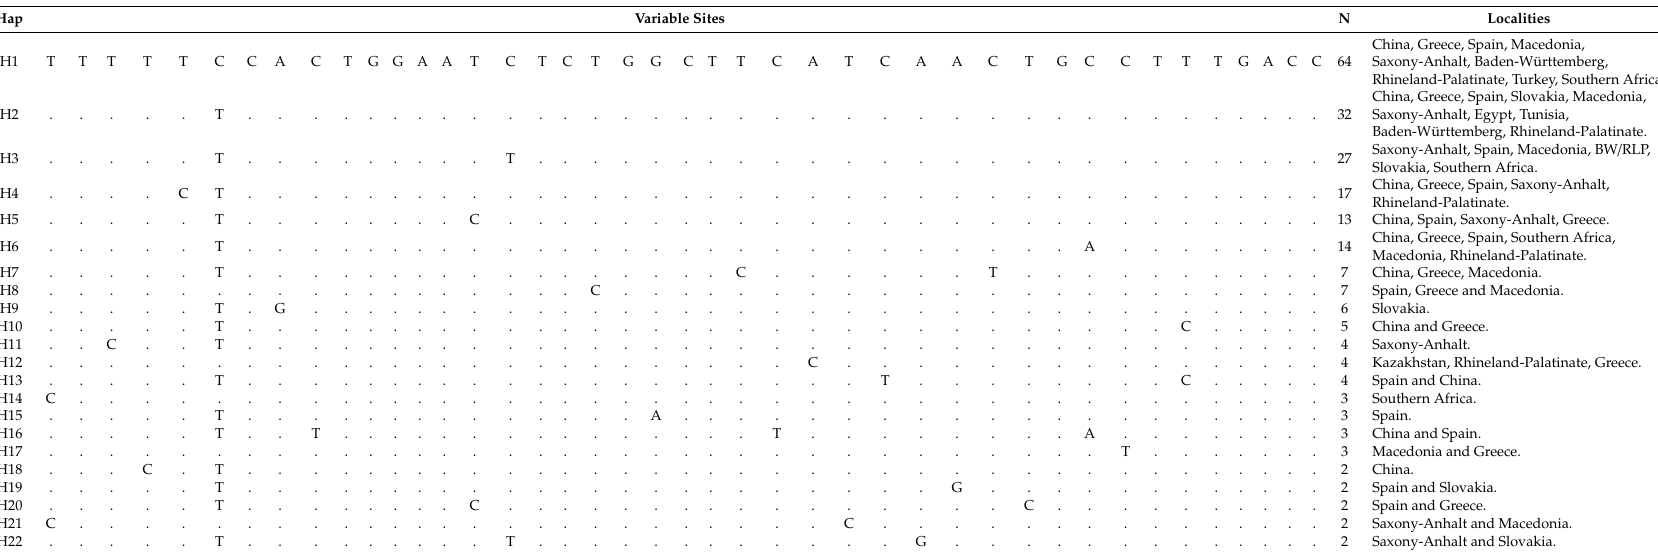
Table 2. Haplotype table based on cytochrome b of Merops apiaster . Single haplotypes were not included. N = haplotype frequency. Hap VariableSites N